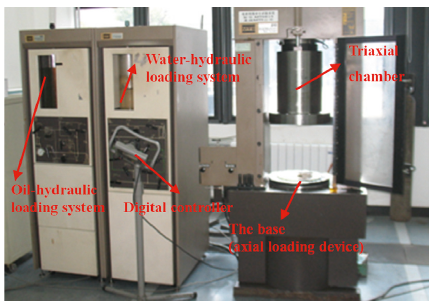
Figure 1: MTS815 rock mechanics test system.